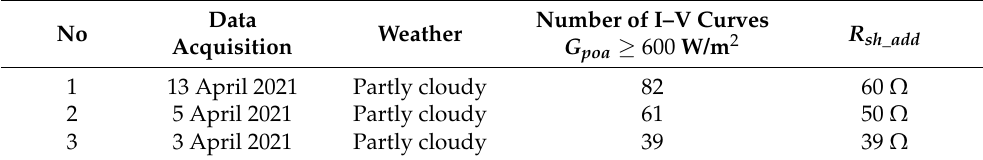
Table 17. Data acquisition for R sh